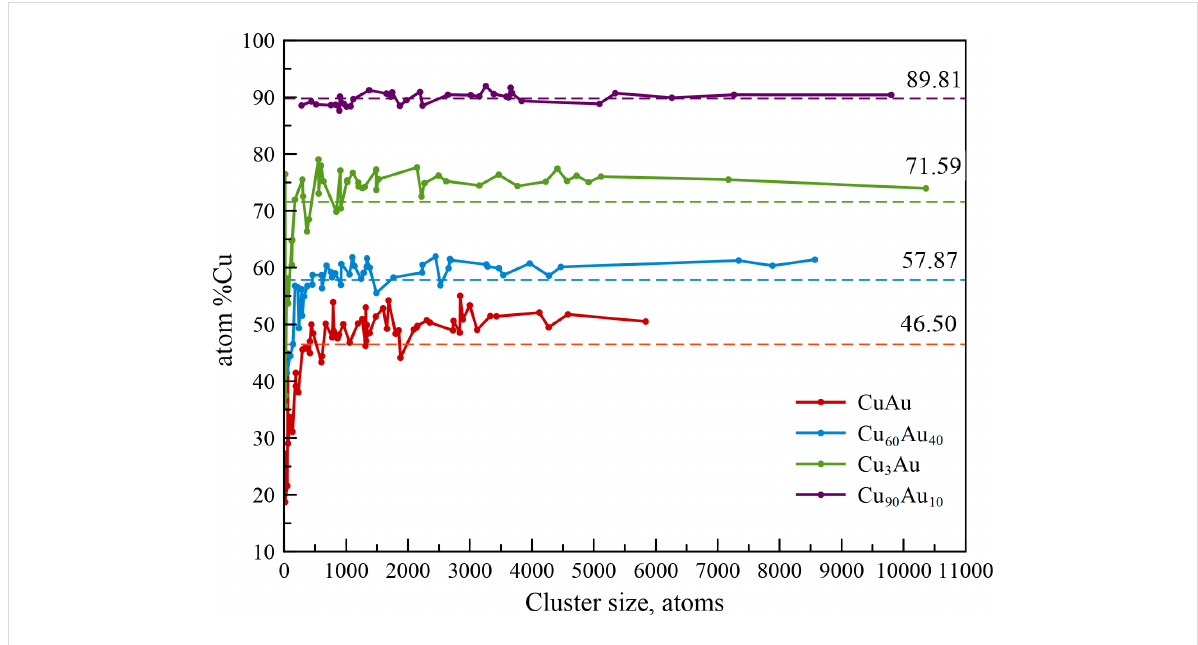
Figure 3: The percentage of copper atoms in binary Cu–Au nanoparticles with different chemical compositions of the initial gas mixture. The analysis was carried out at the final stage of the simulation ( T = 77 K, t = 25 ns). Dashed lines show the average content of copper atoms in binary Cu–Au nanoparticles at various target